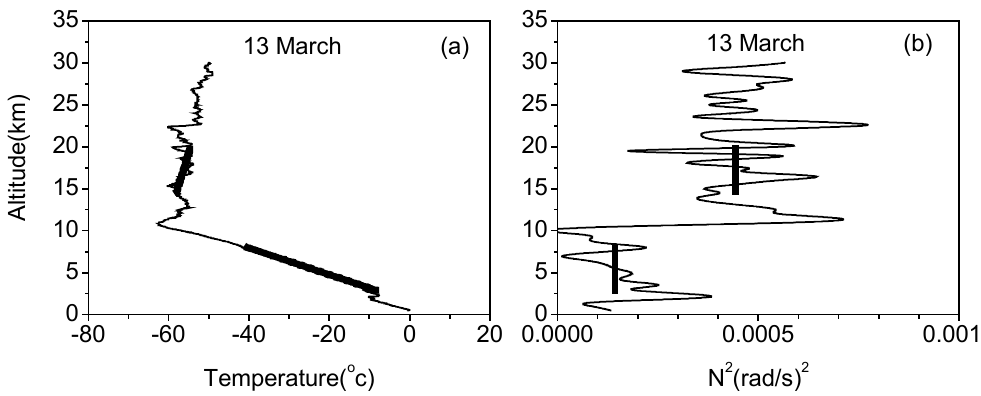
Fig. 1. An example of temperature (a) and N 2 (b) profiles observed on 13 March 2003 during the balloon ascent. The solid lines on the temperature profile show the linear background profiles. Vertical bars on the N 2 profile show the mean values of N 2 and the height ranges used in spectral